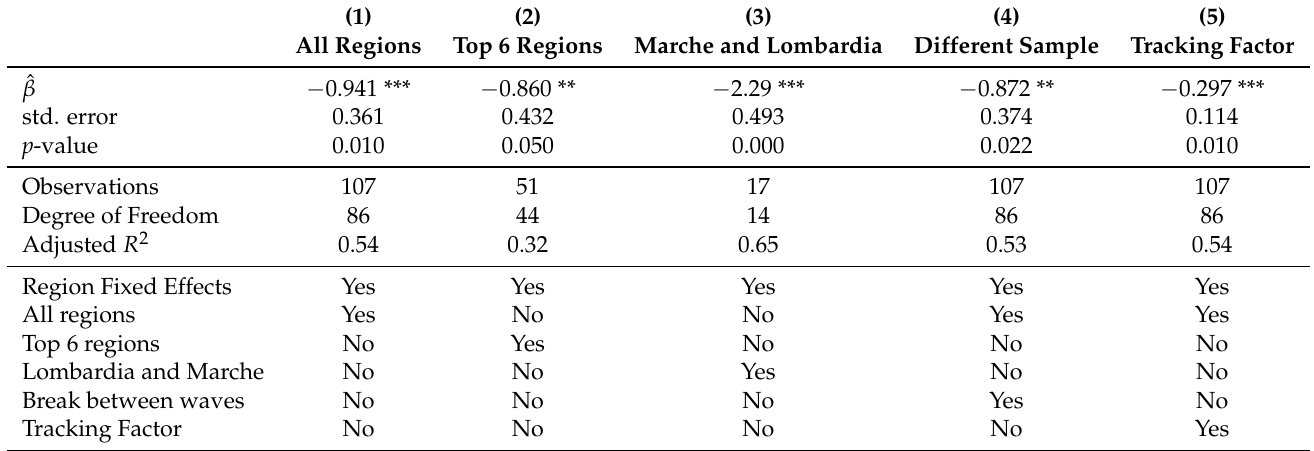
Table 1. Regression